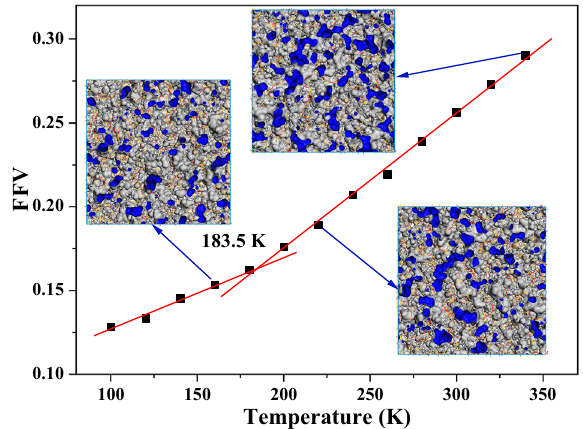
Fig. 9 The glass transition temperature T g of the unaged PDMS model via FFV -temperature dependence.